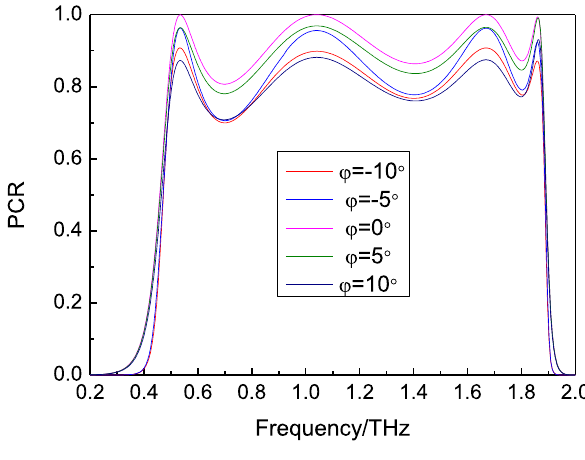
Fig. 7 Relationship between PCR and polarization